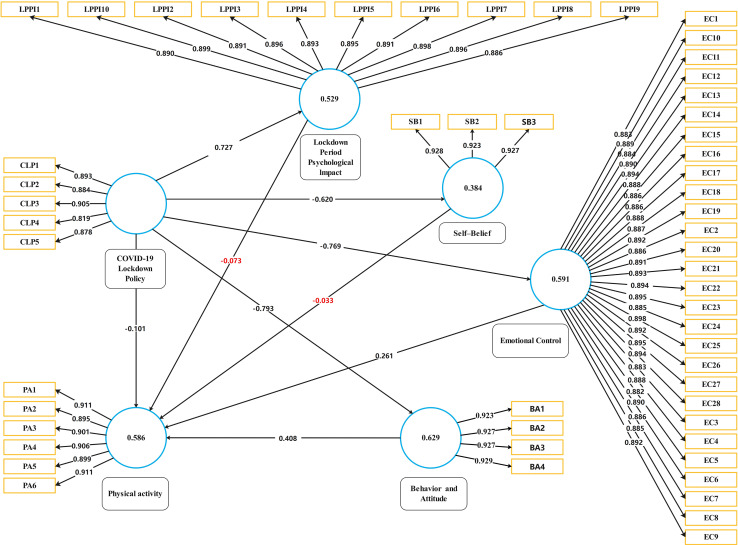
PLS-SEM results.